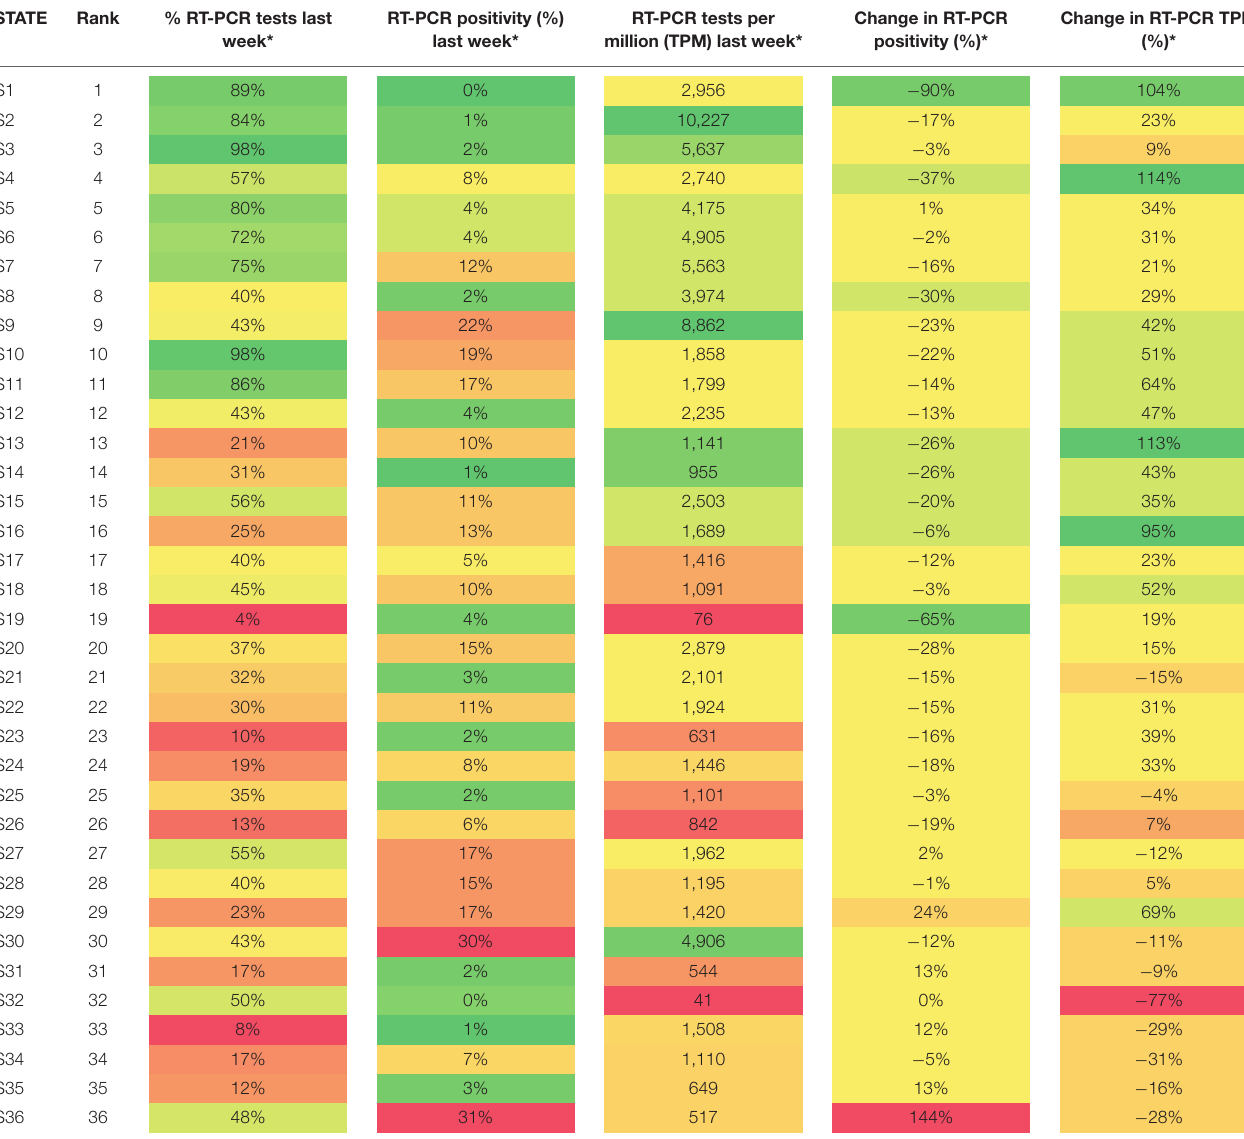
TABLE 1 | State-wise ranking of Indian states on testing performance by the composite index for the week 20–26 November 2020.